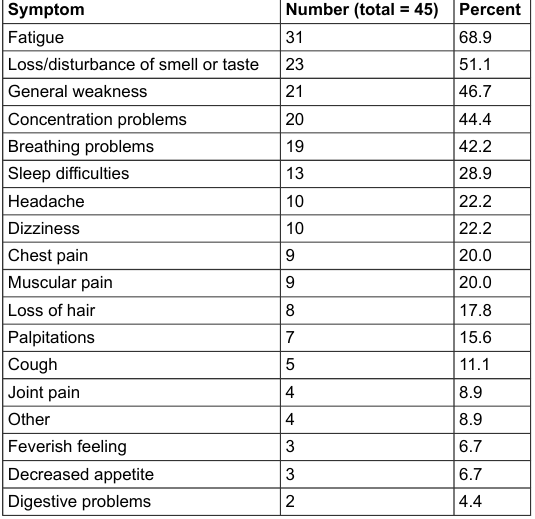
Table 2: Reported symptoms of the 45 participants with a symptom duration of more than 3 months who reported their symptoms. Only participants with ongoing symptoms at the time they completed the survey were asked about their symptoms. Participants could report more than one symptom.